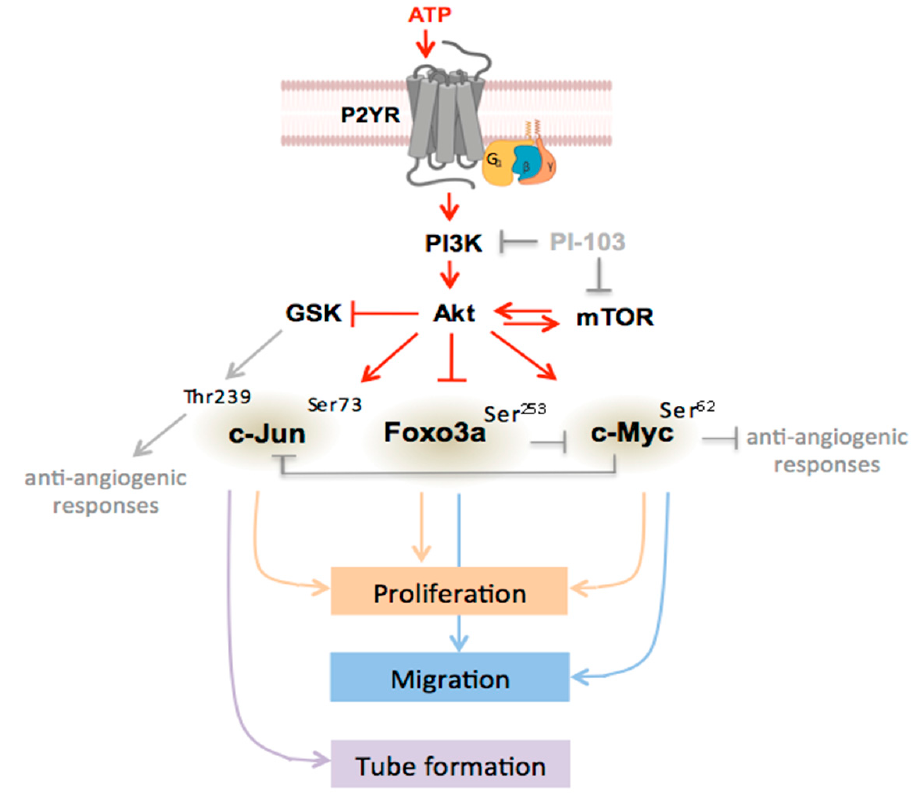
Figure 7. Schematic illustration of ATP-mediated regulation of angiogenic responses in VVEC. Extracellular ATP stimulates purinergic receptor (P2YR)—mediated activation of intracellular PI3K, Akt, mTOR pathways leading to the activation of transcription factors c-Jun, Foxo3a, and c-Myc that have been identified as predominant transcriptional regulators of ATP-mediated angiogenesis in VVECs. Activation of these TFs results in the regulation of functional angiogenic responses—proliferation, migration, and tube formation. In addition, shown here are a potential anti-angiogenic contribution of GSK-mediated c-Jun phosphorylation at Thr239 and a potential angiogenic contribution of c-Myc via the suppression of anti-angiogenic